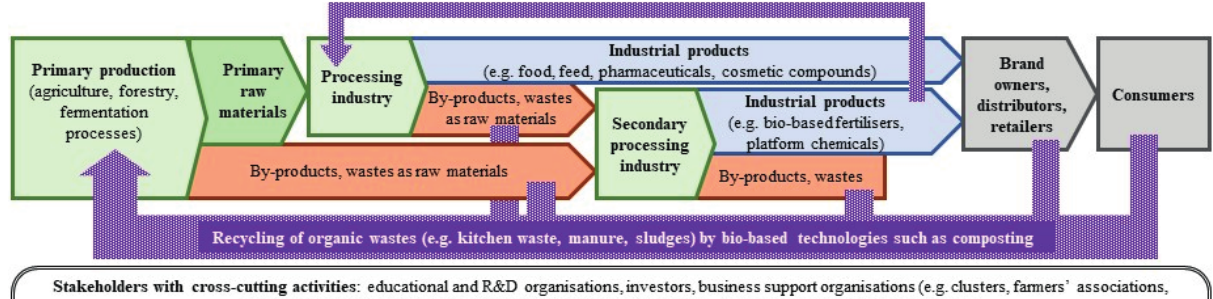
Figure 1. Bio-based value chain structure demonstrating the stakeholders